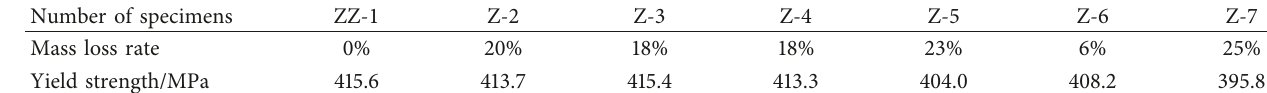
Table 2: Mass loss rate and the yield strength of corrosion steel bar.